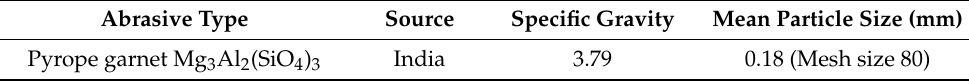
Figure 5. Abrasives for the experiment: ( a ) India garnet; ( b ) particle size distribution. Table 3. Abrasive properties.